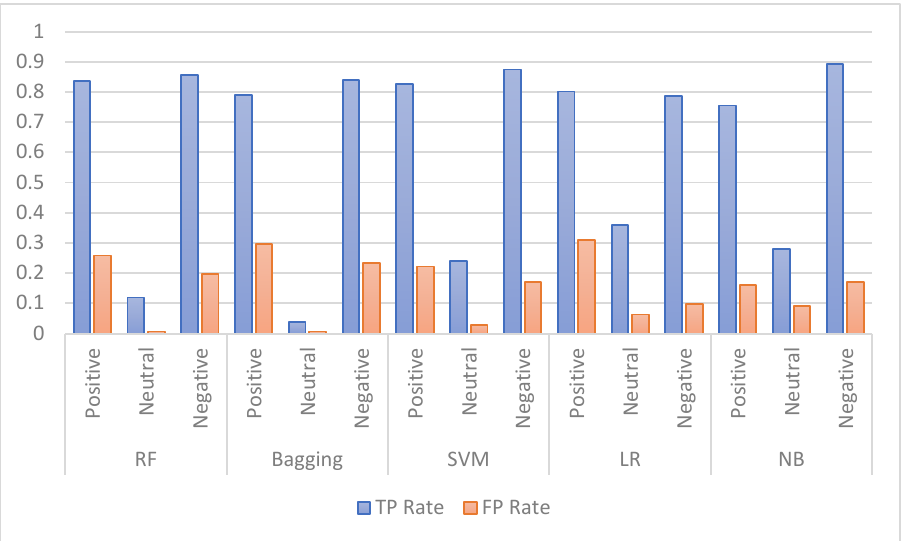
Figure 7. True-positive rate (TP Rate) and false-positive rate (FP Rate) of ML models with original sentiments using concatenated features.